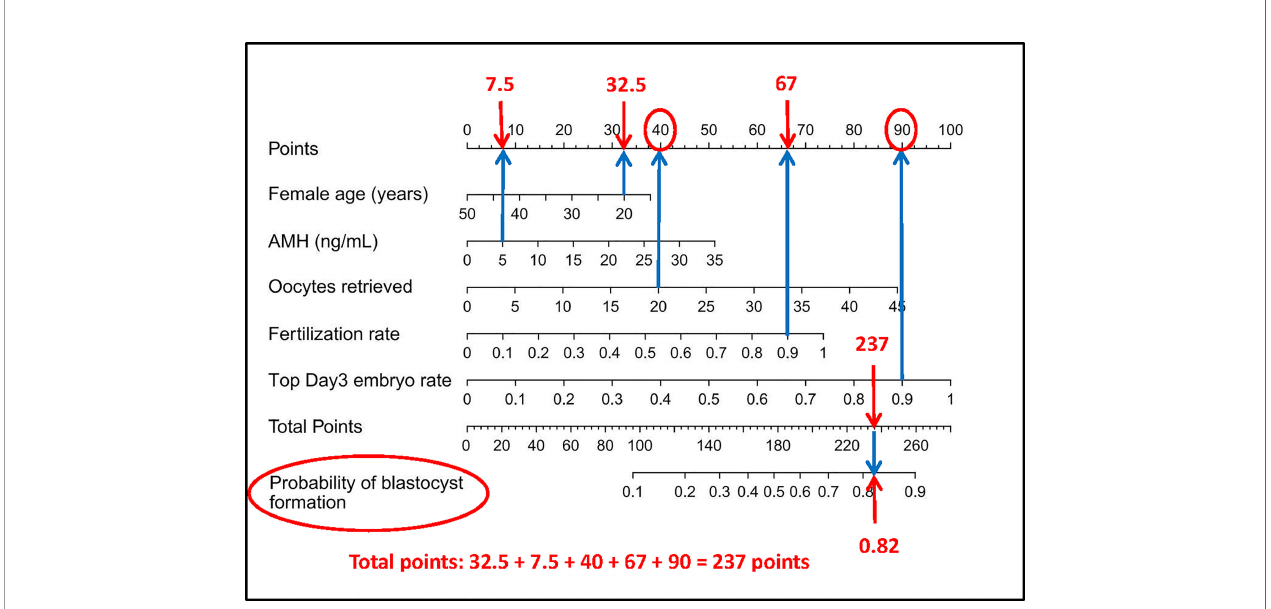
FIGURE 6 | How to read the nomogram. For example, for a 20-year-old woman who suffers from tubal factor infertility (choose the nomogram of tubal factor group: A) with IVF treatment, AMH level of 5 ng/ml, 20 oocytes retrieved, 90% fertilization rate, and 90% top day 3 embryo rate, referring to the top scale, the scores of the above variables (blue arrow) are 32.5 points, 7.5 points, 40 points, 67 points, and 90 points, respectively (red arrow). Then refer to the total points to get the total score of 237 points, and the predicted probability of blastulation rate is 0.82. Finally, the clinician and the patient discuss whether blastocyst culture should be performed. AMH, anti-Mullerian hormone; IVF, in vitro